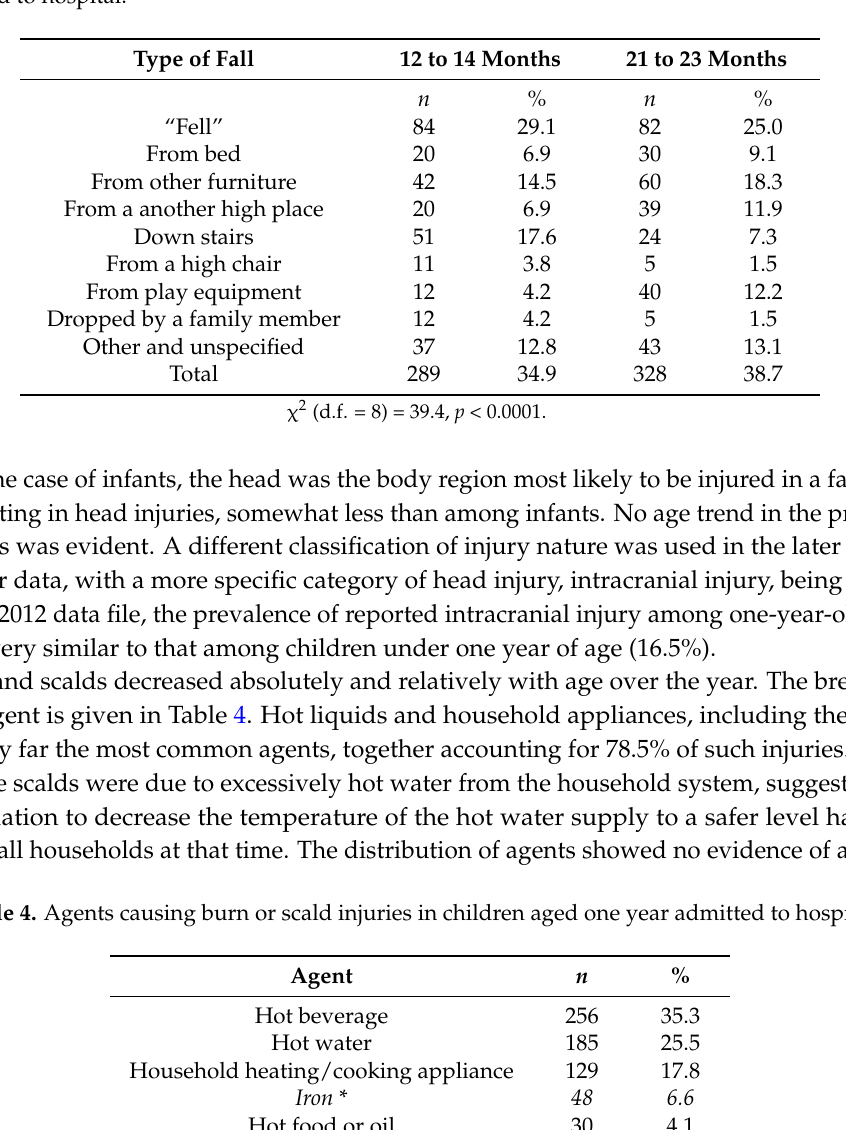
Table 3. Types of falls occurring in the first and fourth trimesters of age in children aged one-year admitted to hospital.